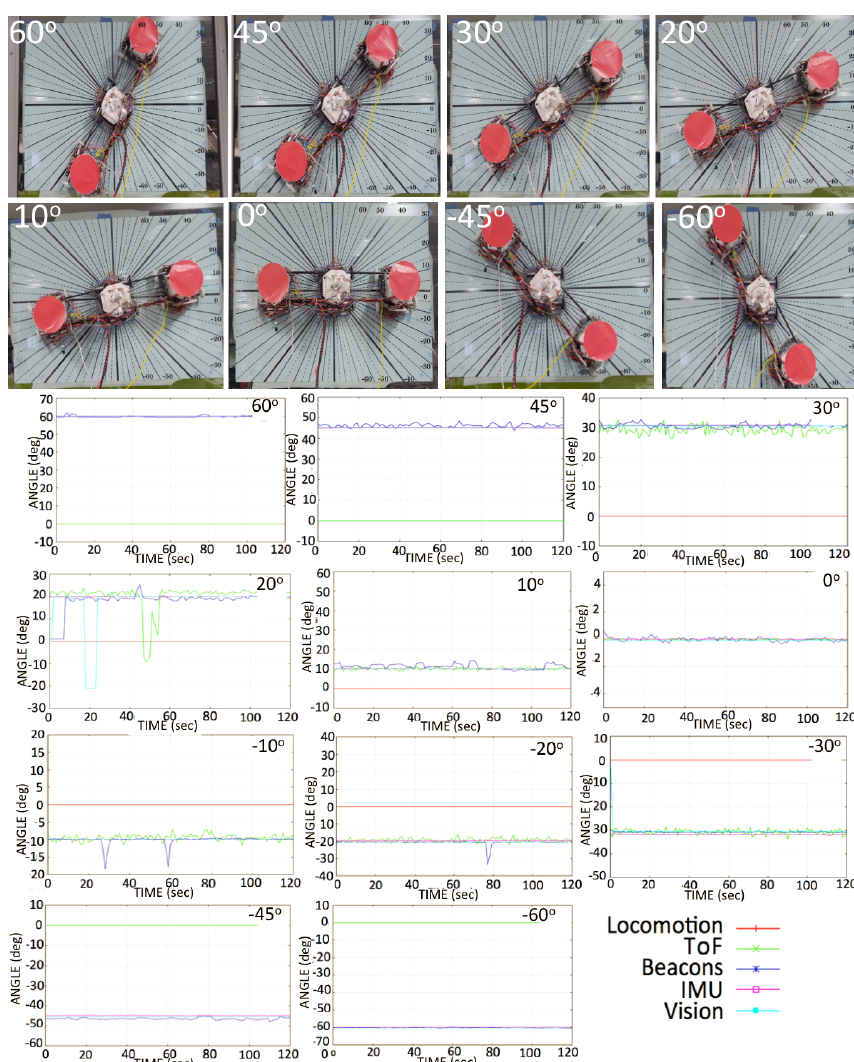
Figure 16. Experimental set-up for static orientations from − 60 ◦ to 60 ◦ . ( Top ) Mantis v2 robot (top view); ( Bottom ) Orientation sensor data plot for each static